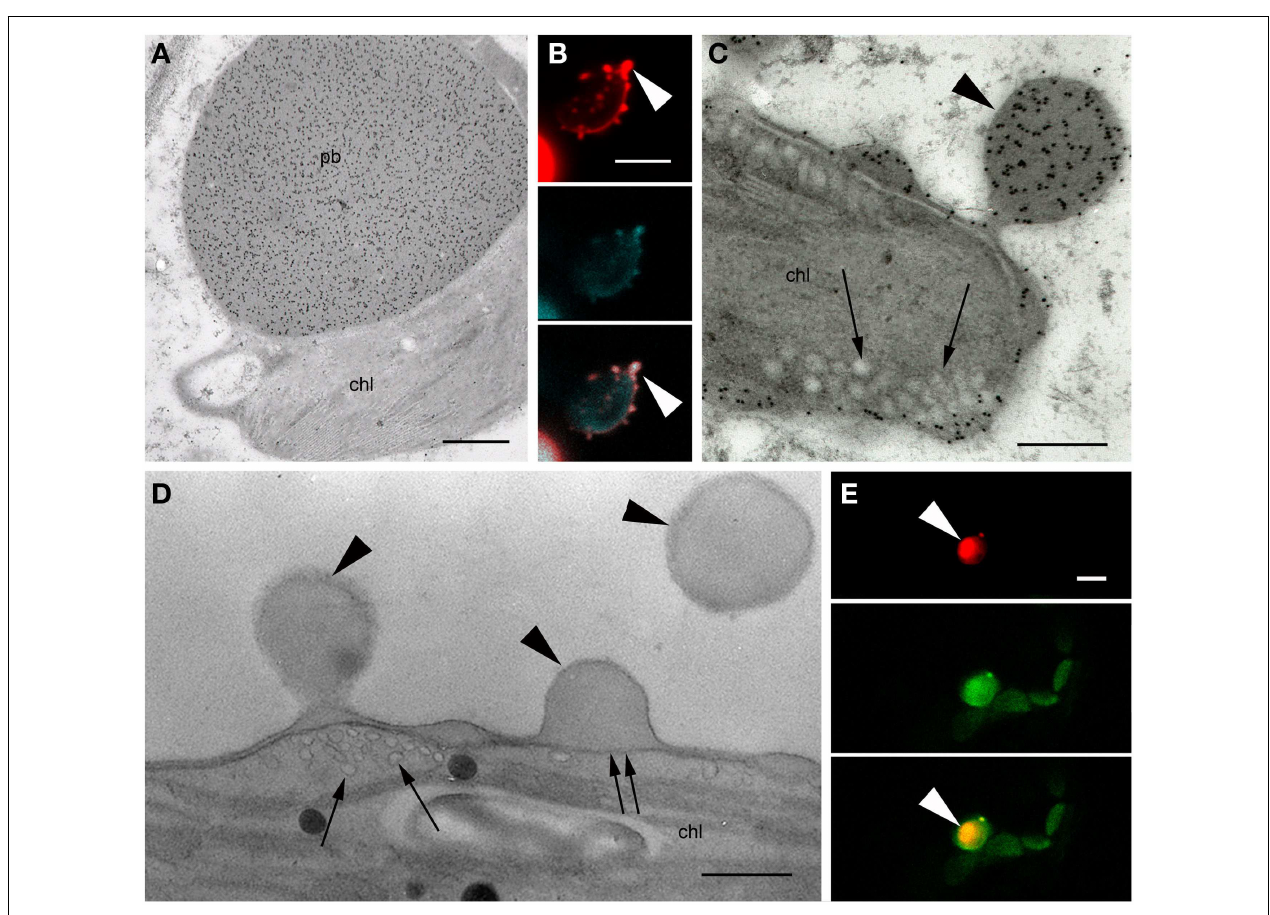
the budding site (arrows). (D) Detection of unsaturated lipids, by electron microscopy. Budding protein bodies are confined by the outer membrane (arrowheads) and the inner envelope membrane (double arrow) of the plastid.Tubular thylakoids can be observed at the budding site (arrows). (E) CLSM image showing red fluorescent protein bodies enclosed by the outer plastid envelope membrane highlighted with aTOC-GFP membrane marker (arrowheads). DsRED (top), GFP (middle) and merged channels (bottom) are shown. Bars = 0.5 µ m (A,D) , 5 µ m (B,E) , or 0.25 µ m (C)